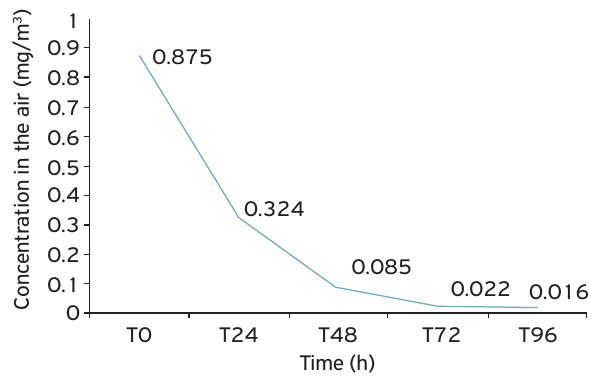
Figure 1. Chlorpyrifos pesticide concentration in the greenhouse